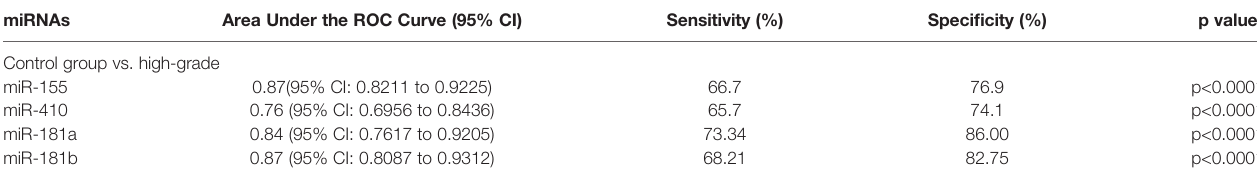
TABLE 4 | Receiver Operating Characteristic (ROC) curves for diagnostic value of circulating miR-181a/b, miR-410 and miR-155 for high-grade glioma patients in after surgery time. miRNAs